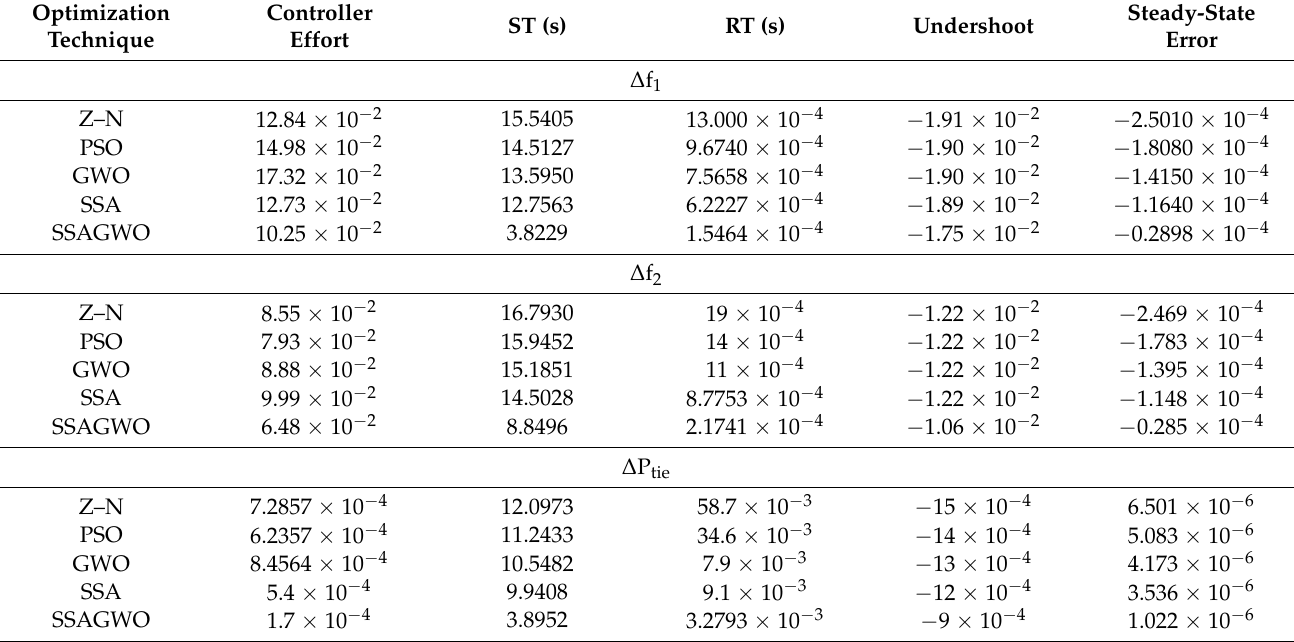
Table 8. Frequency and power deviation in the tie-line power of case III.